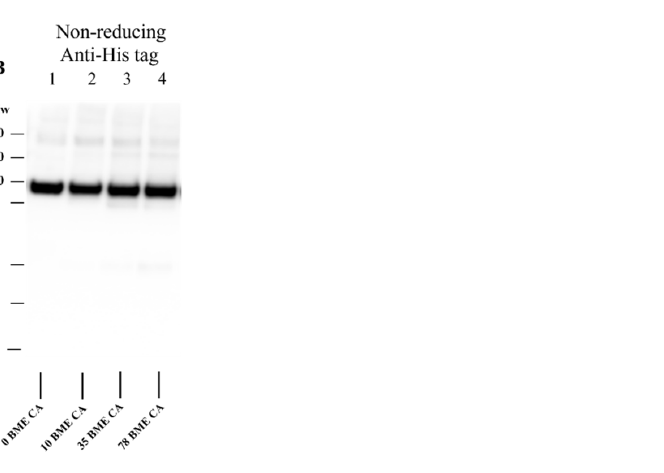
Figure 10. Effects of basement membrane extract chloramines on rhAggrecan. Chloramines were generated on murine basement membrane extract (BME, 20 µ M) exposed to a 50-fold molar excess of HOCl (1 mM). Defined concentration of the preformed chloramines (as indicated; bars labelled BME ‐ CA) was then incubated with rhAggrecan (643 nM) for 24 h at 37 °C in buffer A. The samples were then subjected to gel electrophoresis under reducing ( A ) or nonreducing ( B ) conditions and transfer to membranes before Western blotting with the membranes probed with the anti-His-tag antibody. Molecular mass markers are indicated to the left of each image. Images are representative data from three independent experiments.